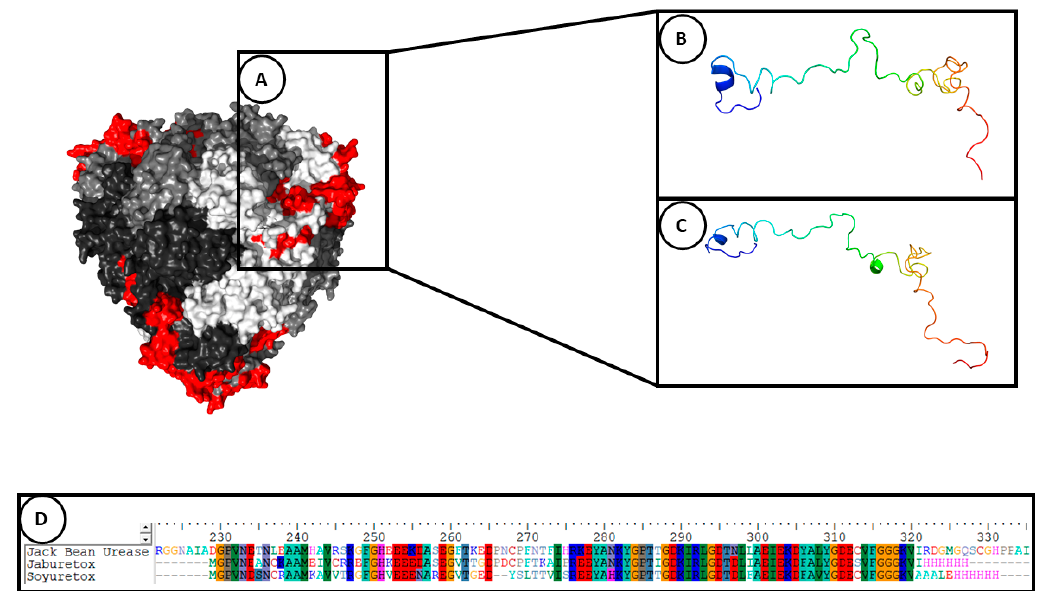
Figure 1. Structural representation of entomotoxic peptides and Jack Bean Urease. ( A ) Graphical representation of the location of the peptides (red) in the protein structure of Jack Bean Urease (pdb: 3LA4). Each monomer of the JBU hexamer is represented with a different shade of grey. ( B ) Jaburetox, ( C ) Soyuretox and ( D ) comparison of the primary sequences.